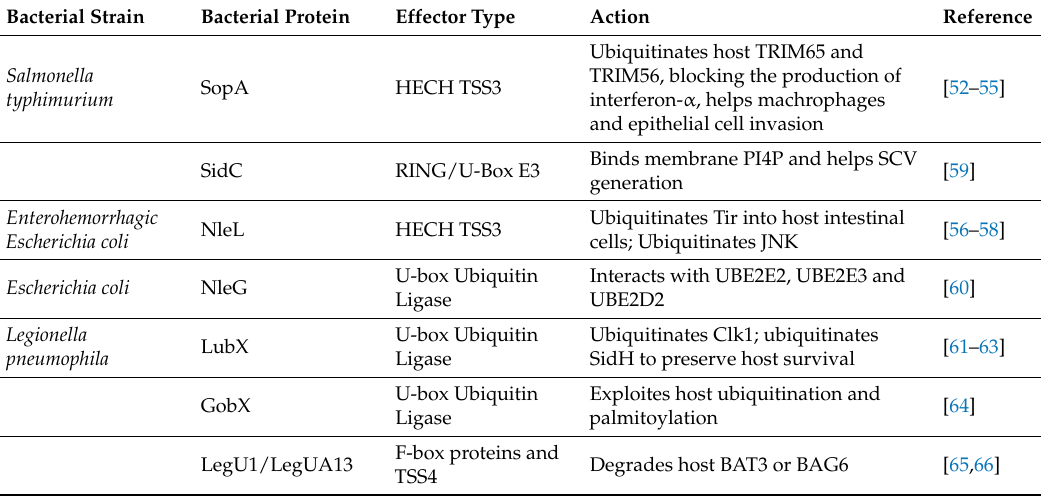
Figure 3. Paradigmatic examples of bacterial exploiting strategies. Schematic drawings depicting the three major and most common exploiting strategies adopted by bacteria to: infect host cells, escape their immune response and neutralize the activation of apoptotic/cell death pathways, and ultimately allow a full a pathogen propagation. In particular, the physiological pathways that are targeted by Salmonella ( A ), enterohemorrhagic Escherichia Coli ( B ), and Legionella ( C ), respectively, are reported in the upper panels. Human proteins are showed in yellow squares, whereas bacterial proteins are showed in blue circles. Table 1. Main strategies executed by commonly and clinically relevant pathogenic bacterial strain to hijack cellular system and evade the host surveillance system.